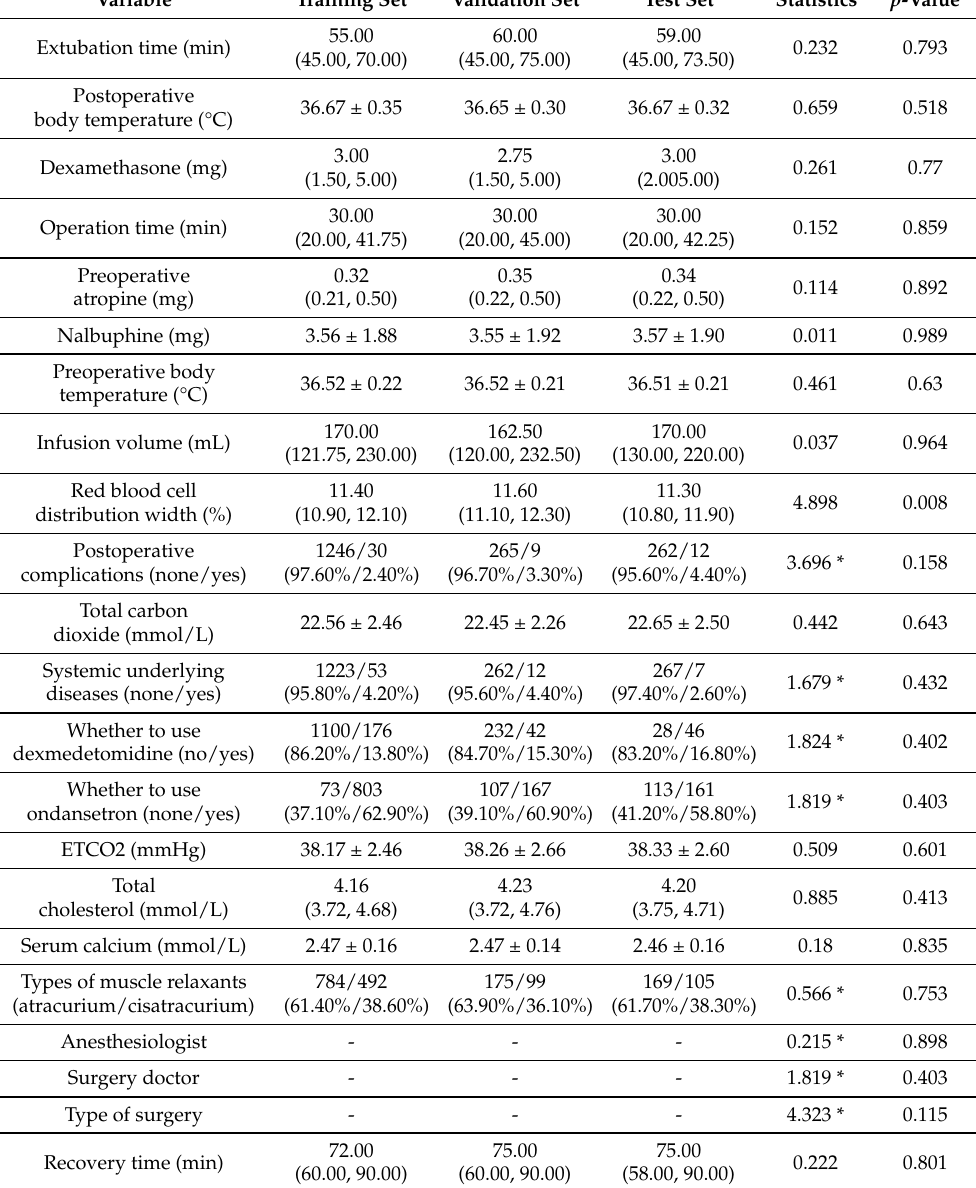
Table 1. Comparative statistics of some variables in the training set, validation set, and testing set, where statistics are the f-values of ANOVA with * is the chi-square test